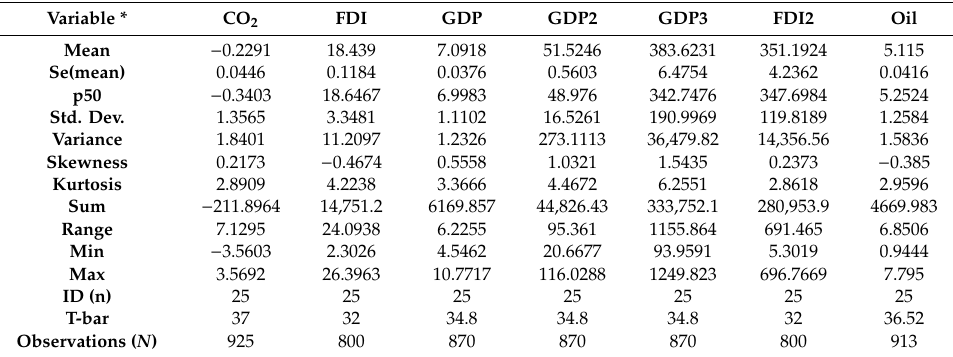
Table 2. The descriptive statistics of all